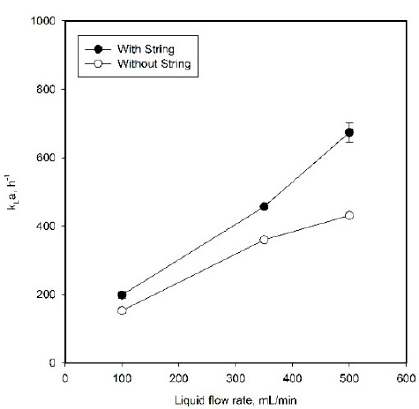
Figure 2. Volumetric mass transfer coefficients for oxygen for the SFR with the string (closed circles) and without the string (open circles).